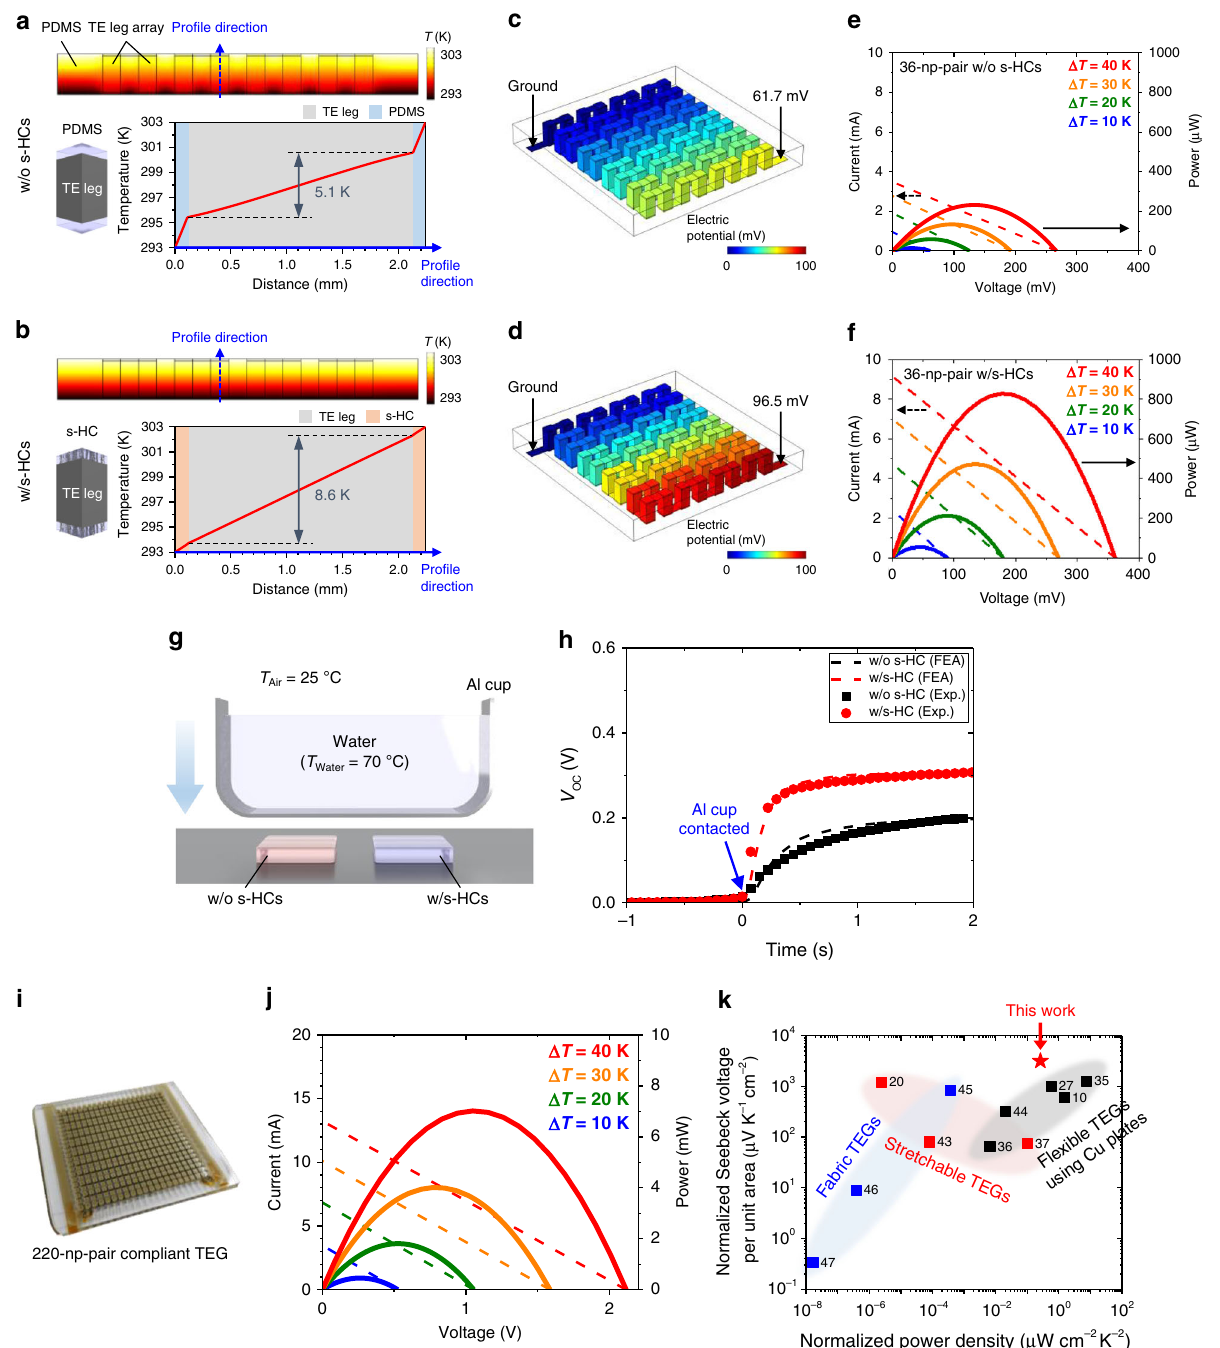
Fig. 3 Effect of s-HCs on the TE performance of the compliant TEG. a , b Finite element analysis (FEA) results showing the temperature distribution on the cross-section of the TEGs without ( a ) and with s-HCs ( b ) for a given temperature difference of 10 K. c , d FEA results showing the open-circuit voltage ( V OC ) of the 36-np-pair TEGs without ( c ) and with s-HCs ( d ) for a given temperature difference of 10 K. e , f Experimentally measured TE performances of 36-np-pair TEGs without ( e ) and with s-HCs ( f ) showing current and power as a function of voltage. g Schematic illustration of the experimental setup for measuring the response of the TEGs without and with s-HCs. h Time-resolved V OC of the two TEGs when the aluminum cup with hot water is abruptly placed in contact with the two TEGs. The dashed lines represent the corresponding FEA results. i Photograph showing the 220-np-pair-compliant TEG. j Experimentally measured TE performance of the 220-np-pair-compliant TEG including current and power as a function of voltage. k Performance comparison of wearable show the performance comparison between the state-of-the-art fl exible/wearable TEGs 10,20,27,35 – 37,43 – 47 . Our compliant TEG with the s-HCs shows the highest normalized Seebeck voltage per a Δ T Applied of 40 K (Fig. 3j). Figure 3k and Supplementary Table 3 unit area, the V OC normalized by the Δ T , and the dimension of